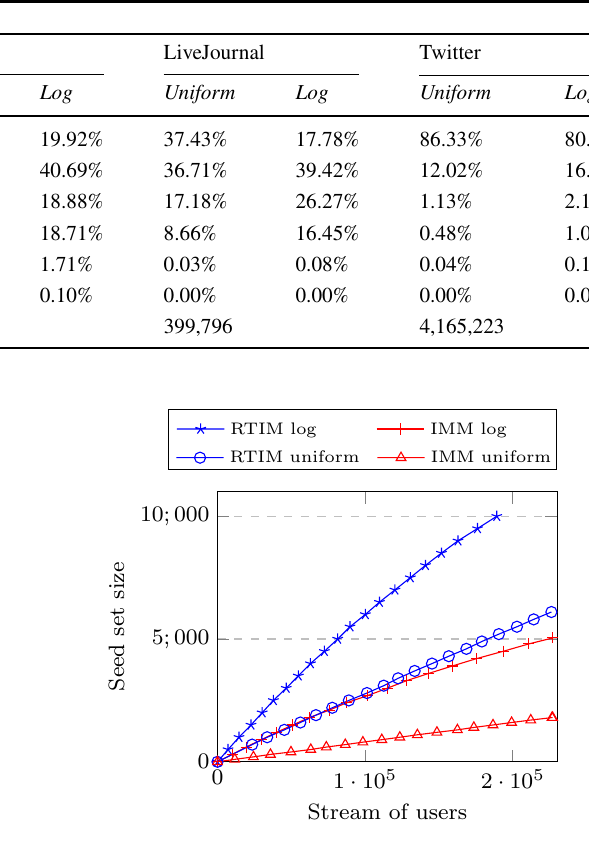
Fig. 4 Seed set size evolution with YouTube